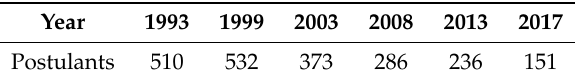
Table 1. Decreasing Number of Postulants.